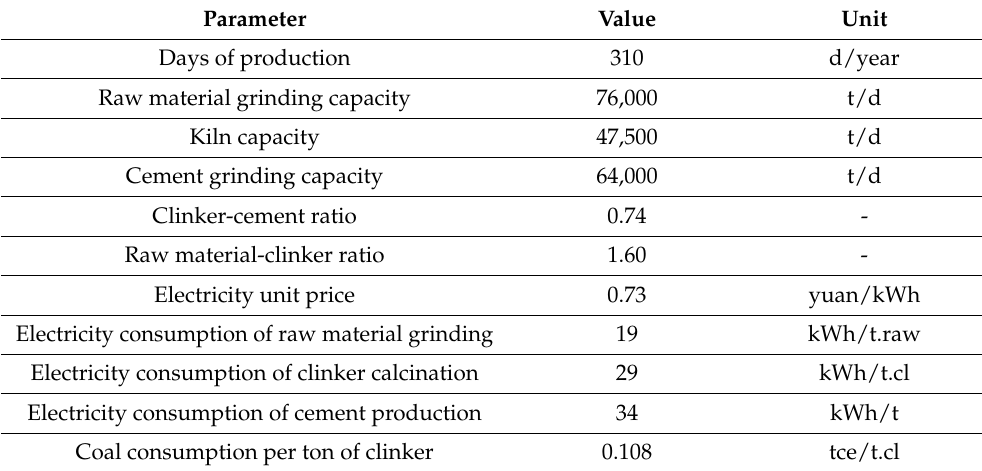
Table 2. Production data of T Cement.